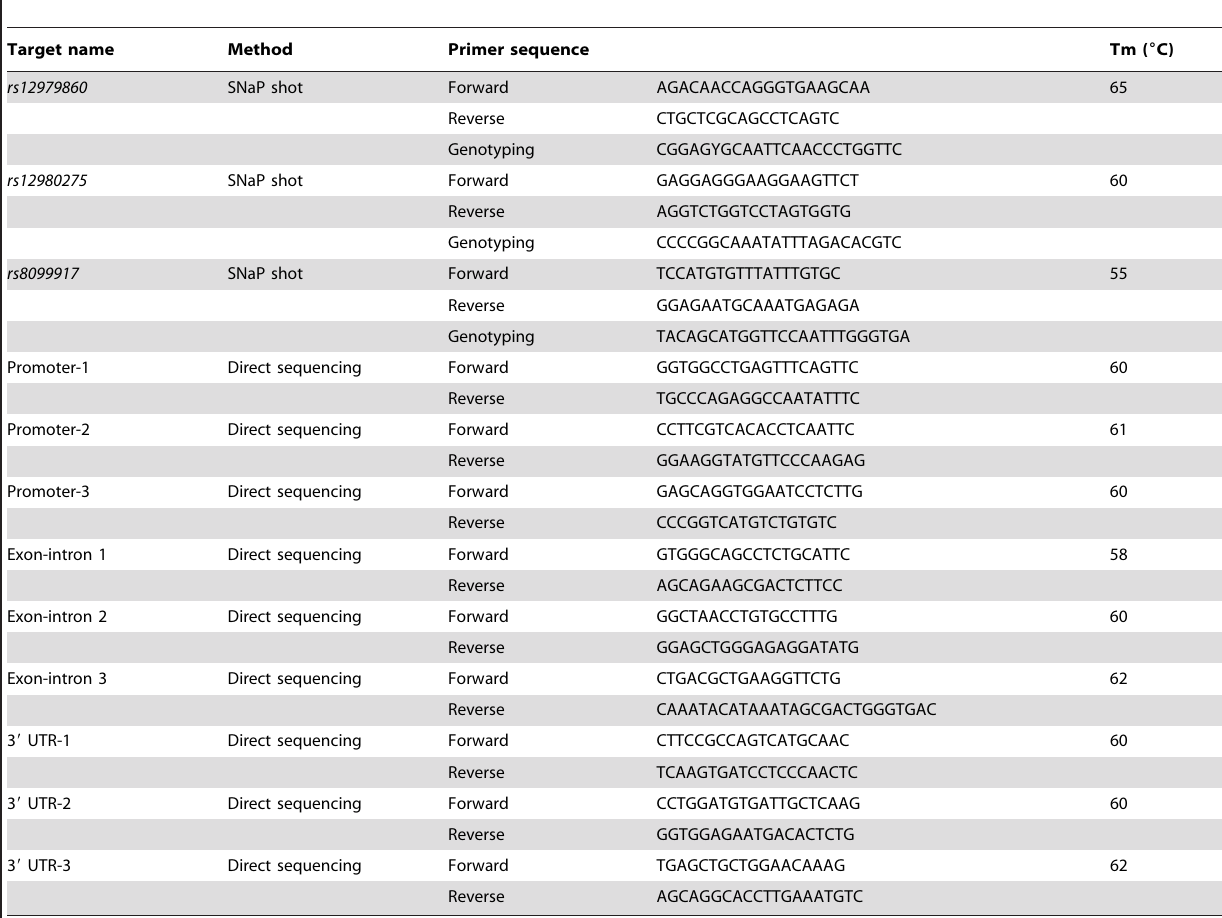
Table 1. Primer sequence and polymerase chain reaction